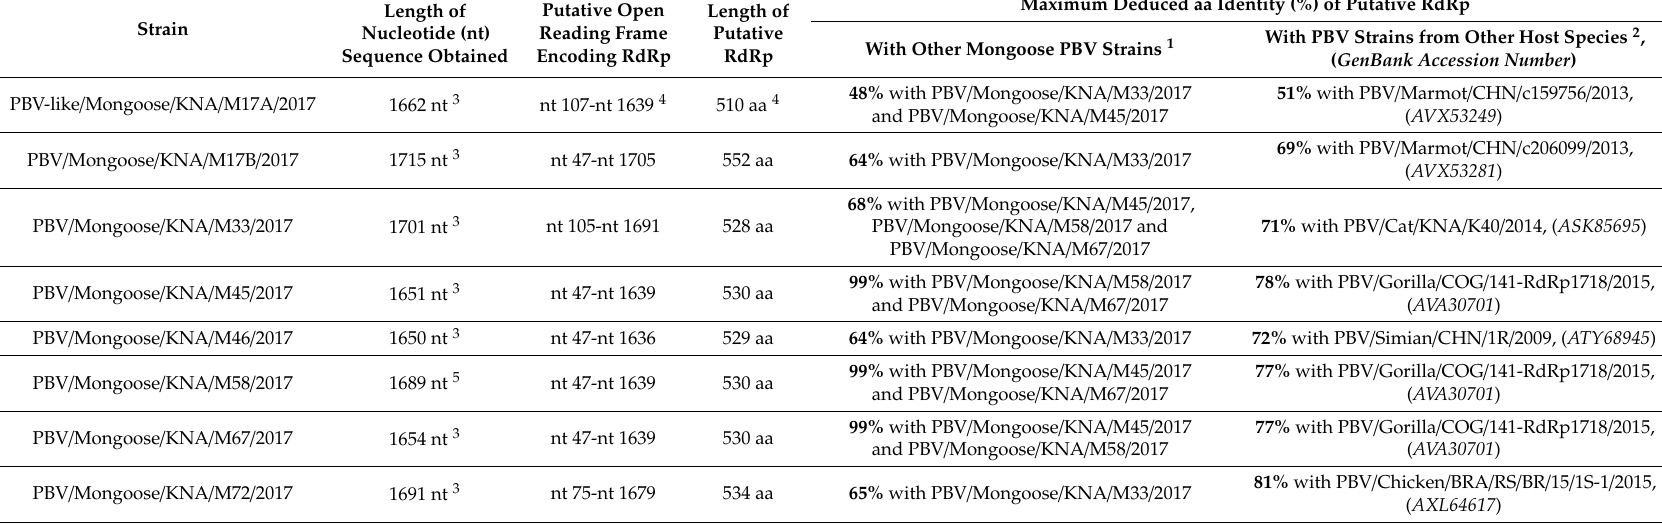
Table 1. Features of gene segment-2, and deduced amino acid (aa) identities of the putative RNA-dependent RNA polymerase (RdRp) of picobirnavirus (PBV) and PBV-like strains detected in the small Indian mongoose on the Caribbean island of St.